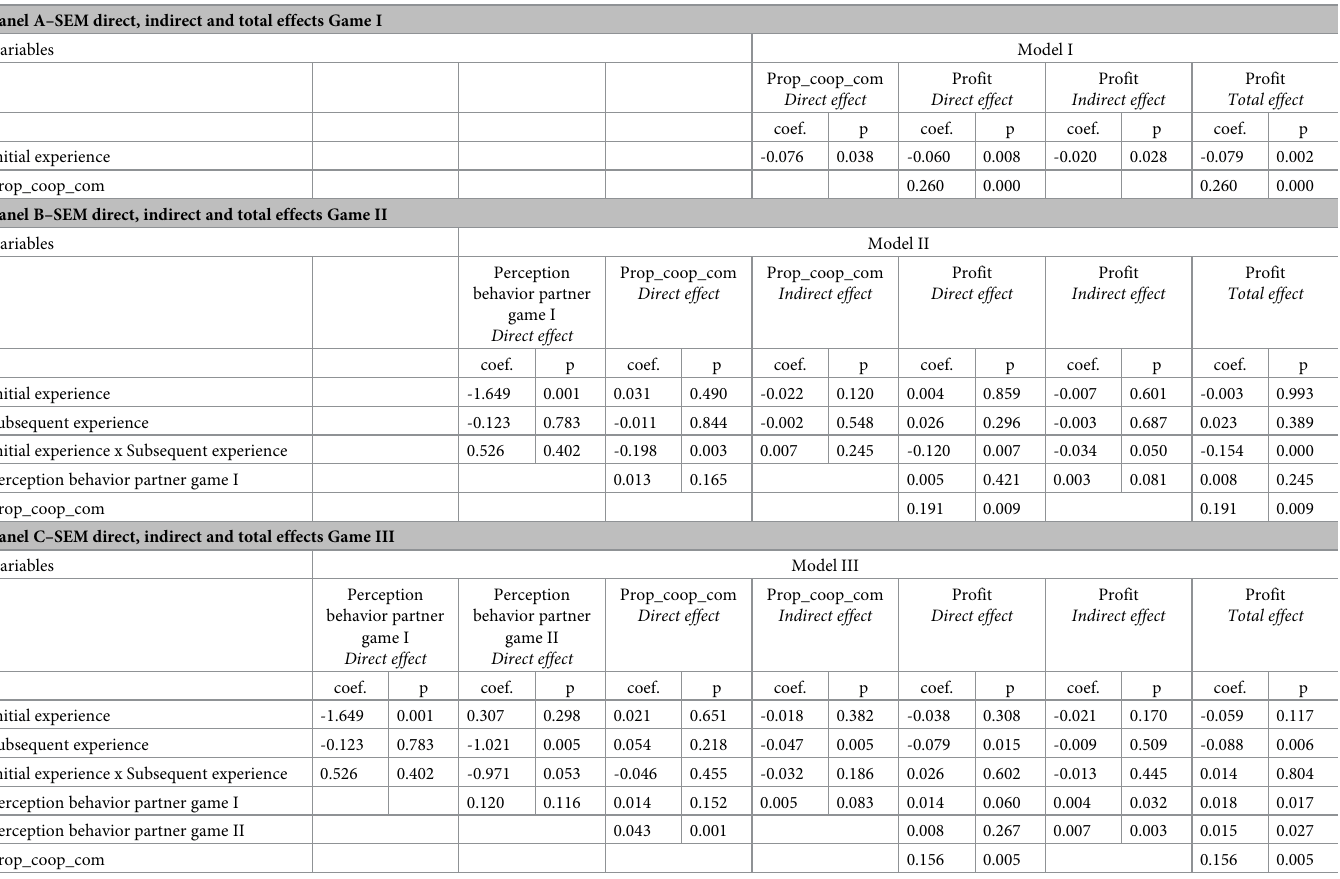
Table 4. Mediation